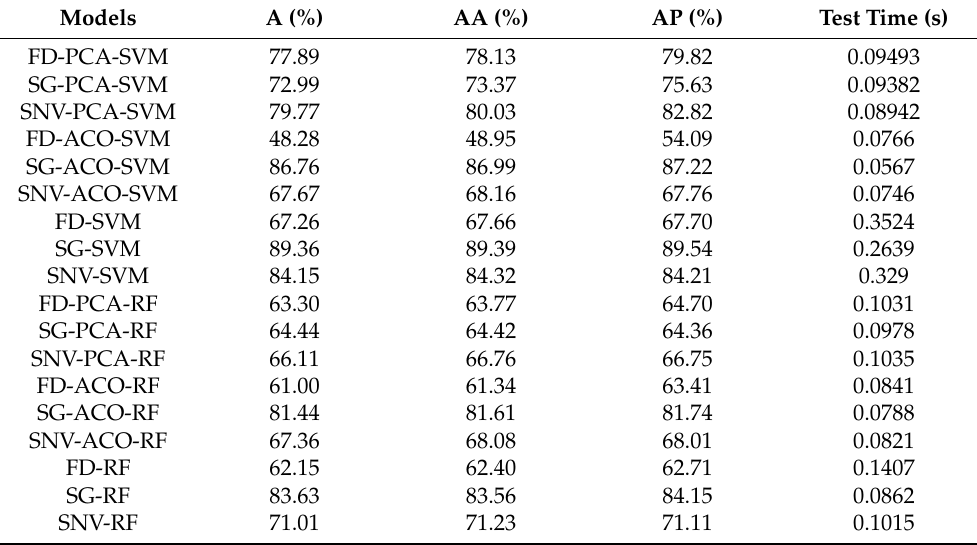
Table 3. The total accuracy, average accuracy and average precision of the 18 combined